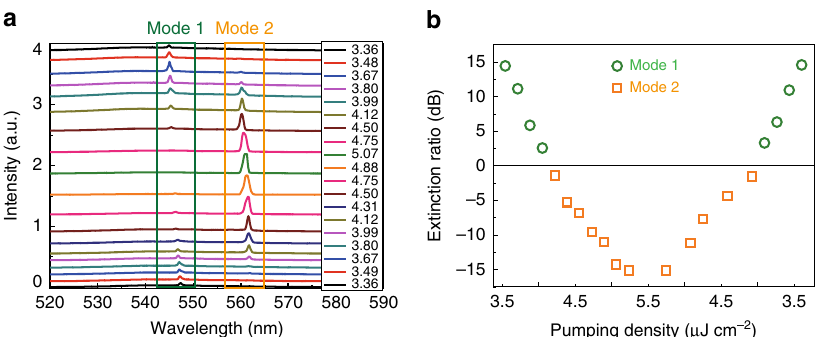
Fig. 3 The reversible process. a The evolution of lasing spectrum with the increase and decrease of pumping density ( μ J cm − 2 ). b The corresponding extinction ratio in ( a )